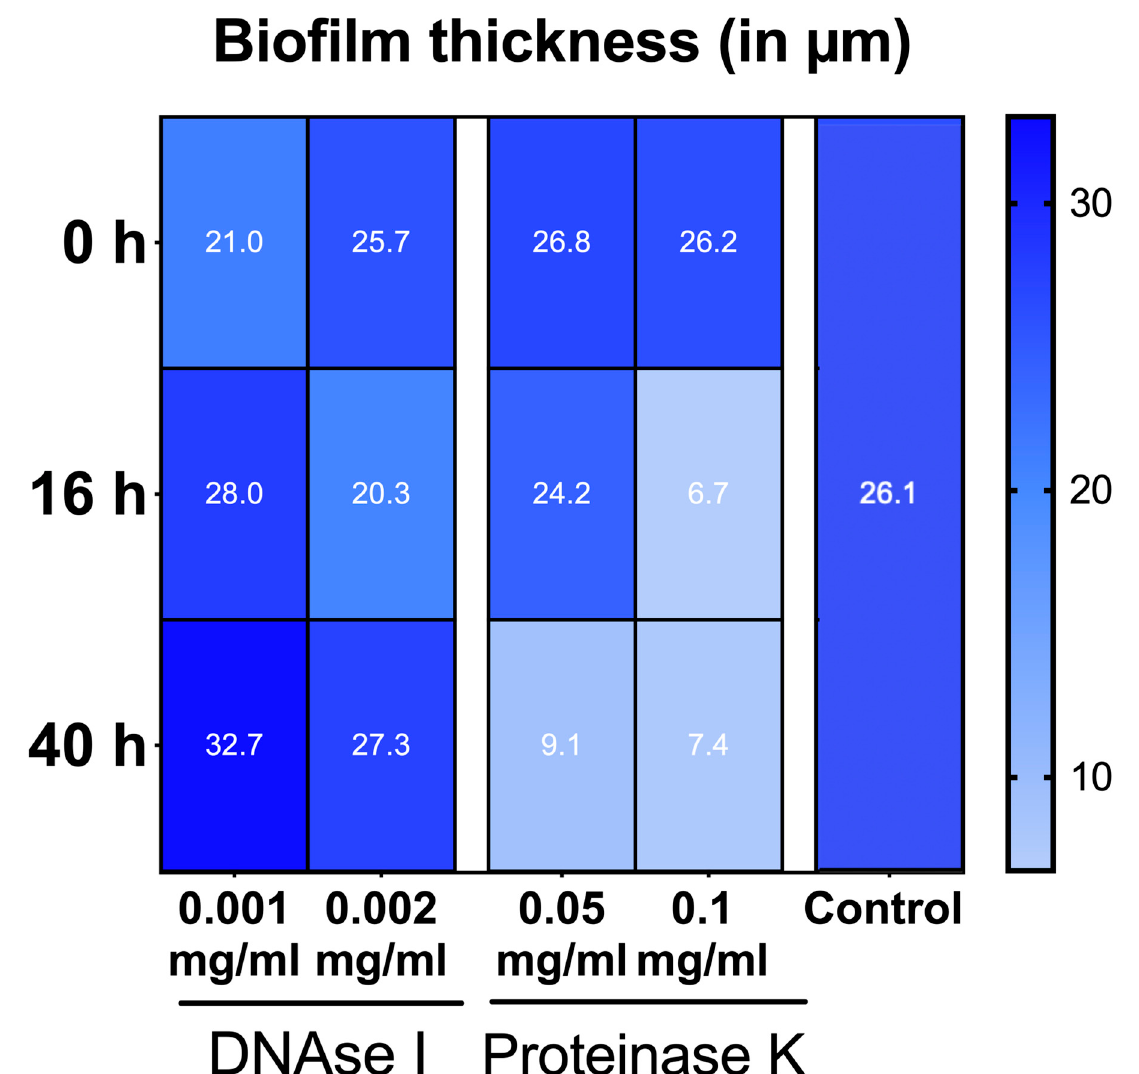
Figure 5. Heat maps of the mean thickness of multispecies biofilms after one-hour exposure to DNase I (0.001 mg/mL, 0.002 mg/mL) and proteinase K (0.05 mg/mL, 0.1 mg/mL) at intervals of 0 h, 17 h, 40 h. After visualization of the treated biofilms with immunofluorescence (IF) and confocal laser scanning microscopy (CLSM) using anti-DNA antibodies, streptavidin (Cy3), calcofluor, SYPRO Ruby and YoPro-1/Sytox, the quantitative analysis of the CLSM images was conducted with IMARIS.